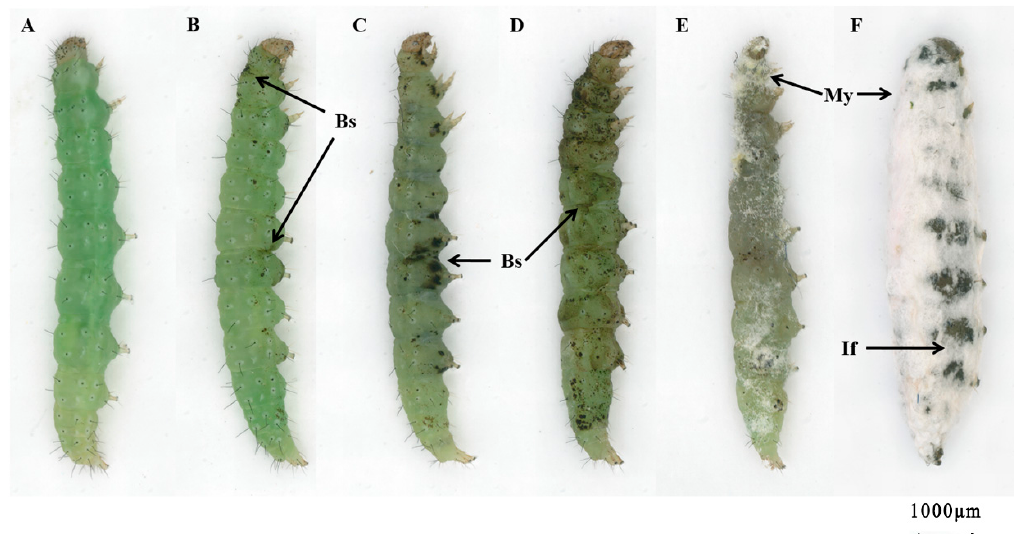
Figure 1. The external symptoms of Plutella xylostella larvae exposed to Cordyceps fumosorosea strain IFCF01, observed under a stereoscope. ( A ) Control group larva; ( B ) black spots (Bs) appeared on the larval cuticle at 8 h post-exposure; dark spots appeared on the entire body of diamondback moth larvae after 16 h ( C ) and 24 h ( D ) post-exposure; ( E ) mycelia (My) develop on the dead larval cadaver after 48 h post-exposure, while intersegmental folds (If) showed dense mycelial mass; ( F ) mycelia entirely covered the cadaver after 72 h post-exposure.